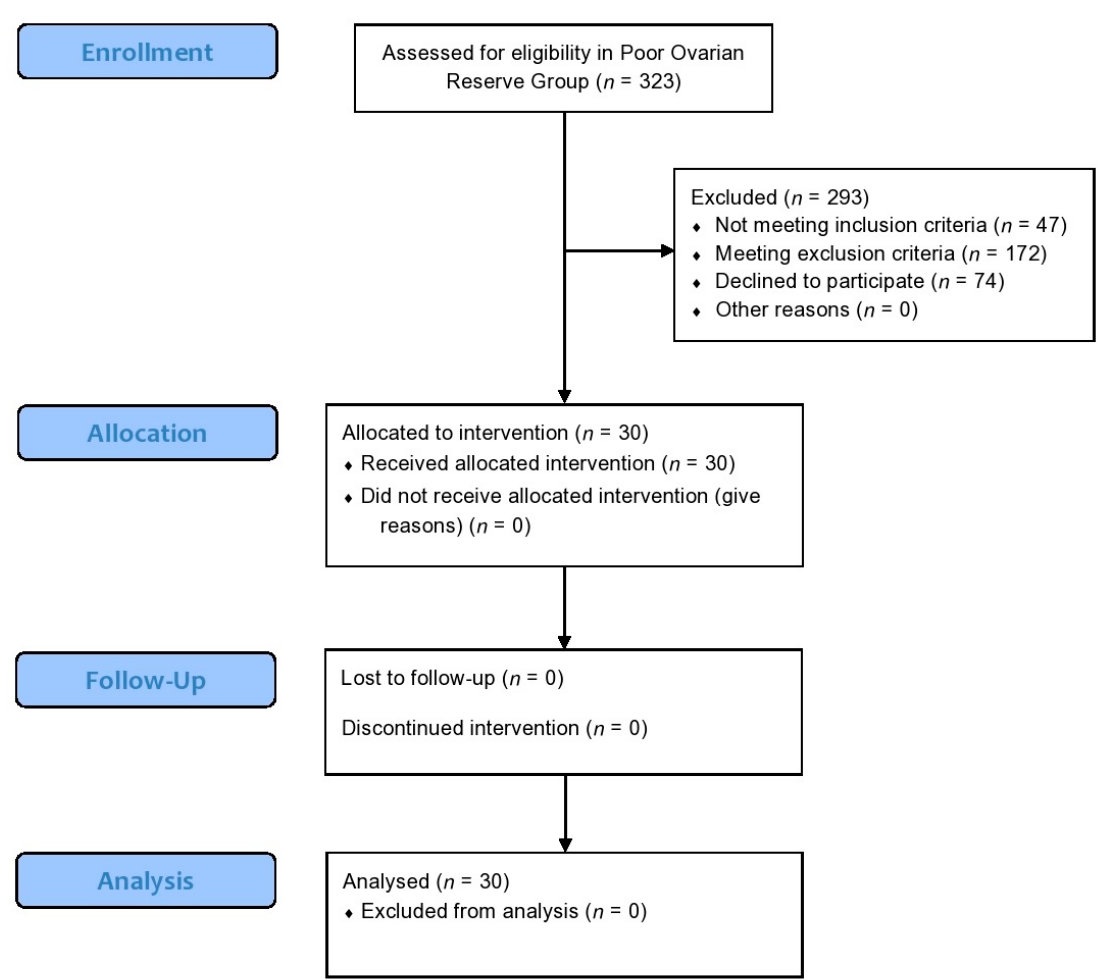
Figure 2. A modified version of CONSORT flow-chart presenting enrollment, allocation, follow-up and analysis of participants regarding the Poor Ovarian Reserve pilot study.